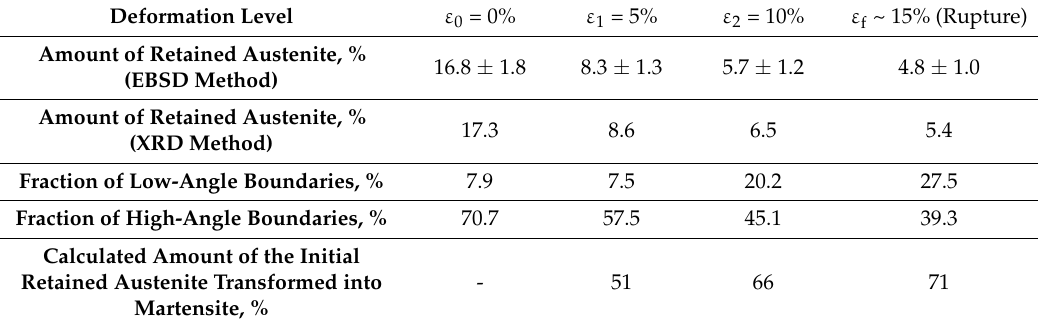
Figure 7. Change of retained austenite fraction as a function of strain level. Table 3. Amount of retained austenite at different deformation levels determined using the EBSD and XRD methods.